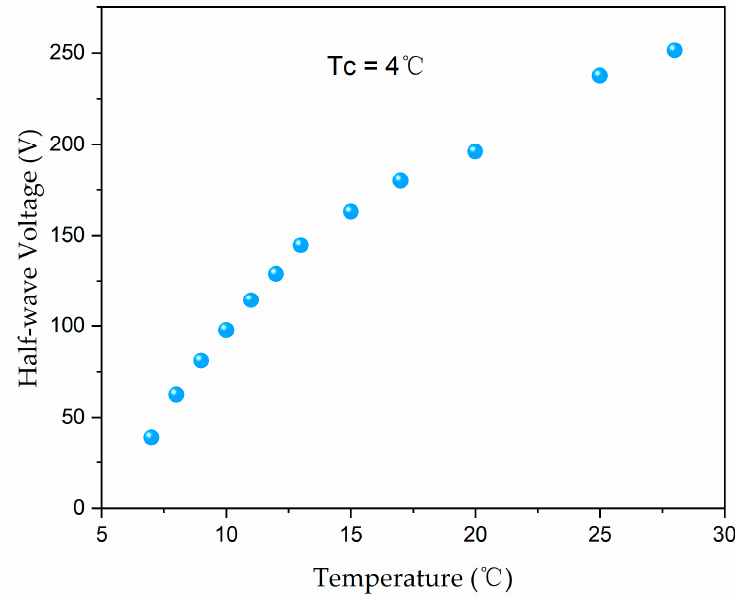
Figure 6. Change of half-wave voltage with temperature.